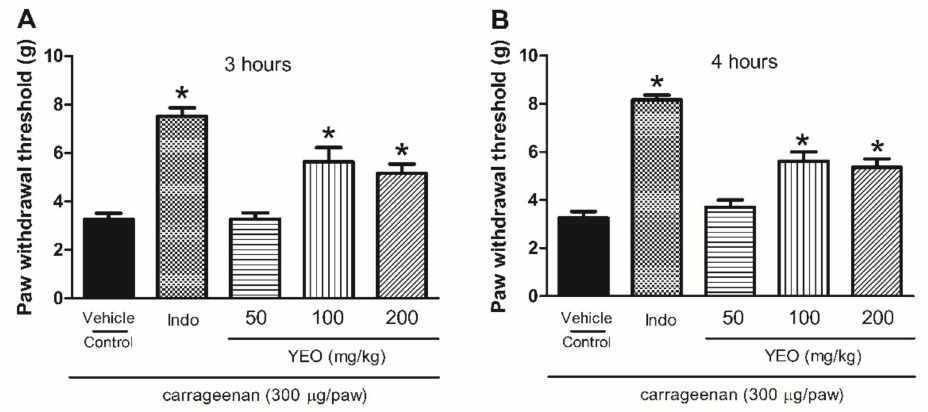
Figure 6. Effect of YEO treatments on carrageenan-induced mechanical hyperalgesia in Swiss mice. The figure shows the values at 3 ( A ) and 4 ( B ) h after the carrageenan injection in the control (vehicle), YEO (50, 100 and 200 mg/kg), and indomethacin (5 mg/kg) groups. * p < 0.05 compared to the control group (ANOVA, Newman–Keul